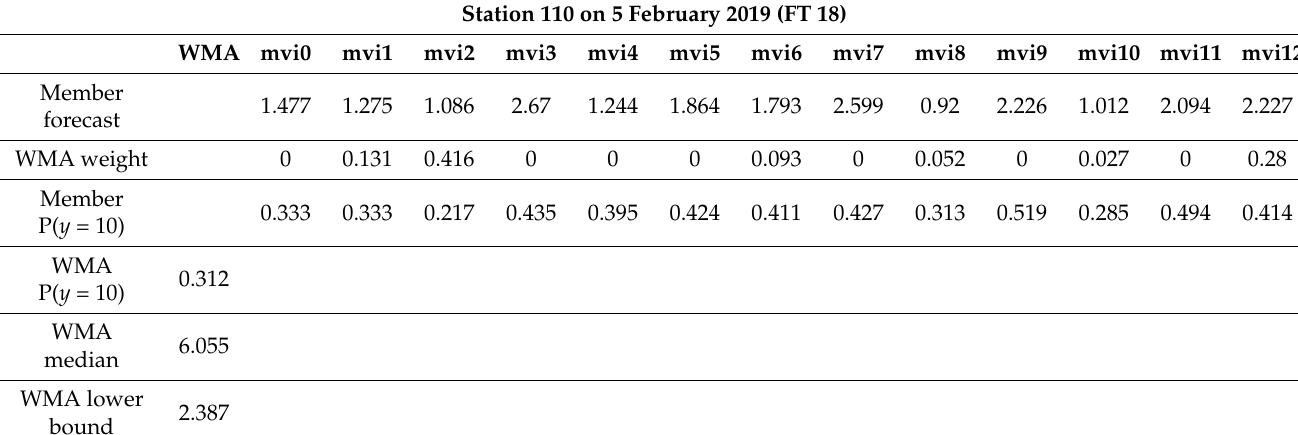
Table 5. WMA outputs. The member forecast, WMA median, WMA lower bound, and observation are in units of km.